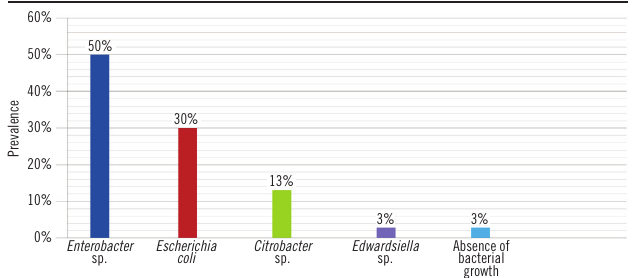
figurE 1 − Prevalence of microorganisms isolated from PU exudate among internal medicine inpatients, Petrolina (PE) PU: pressure ulcer.